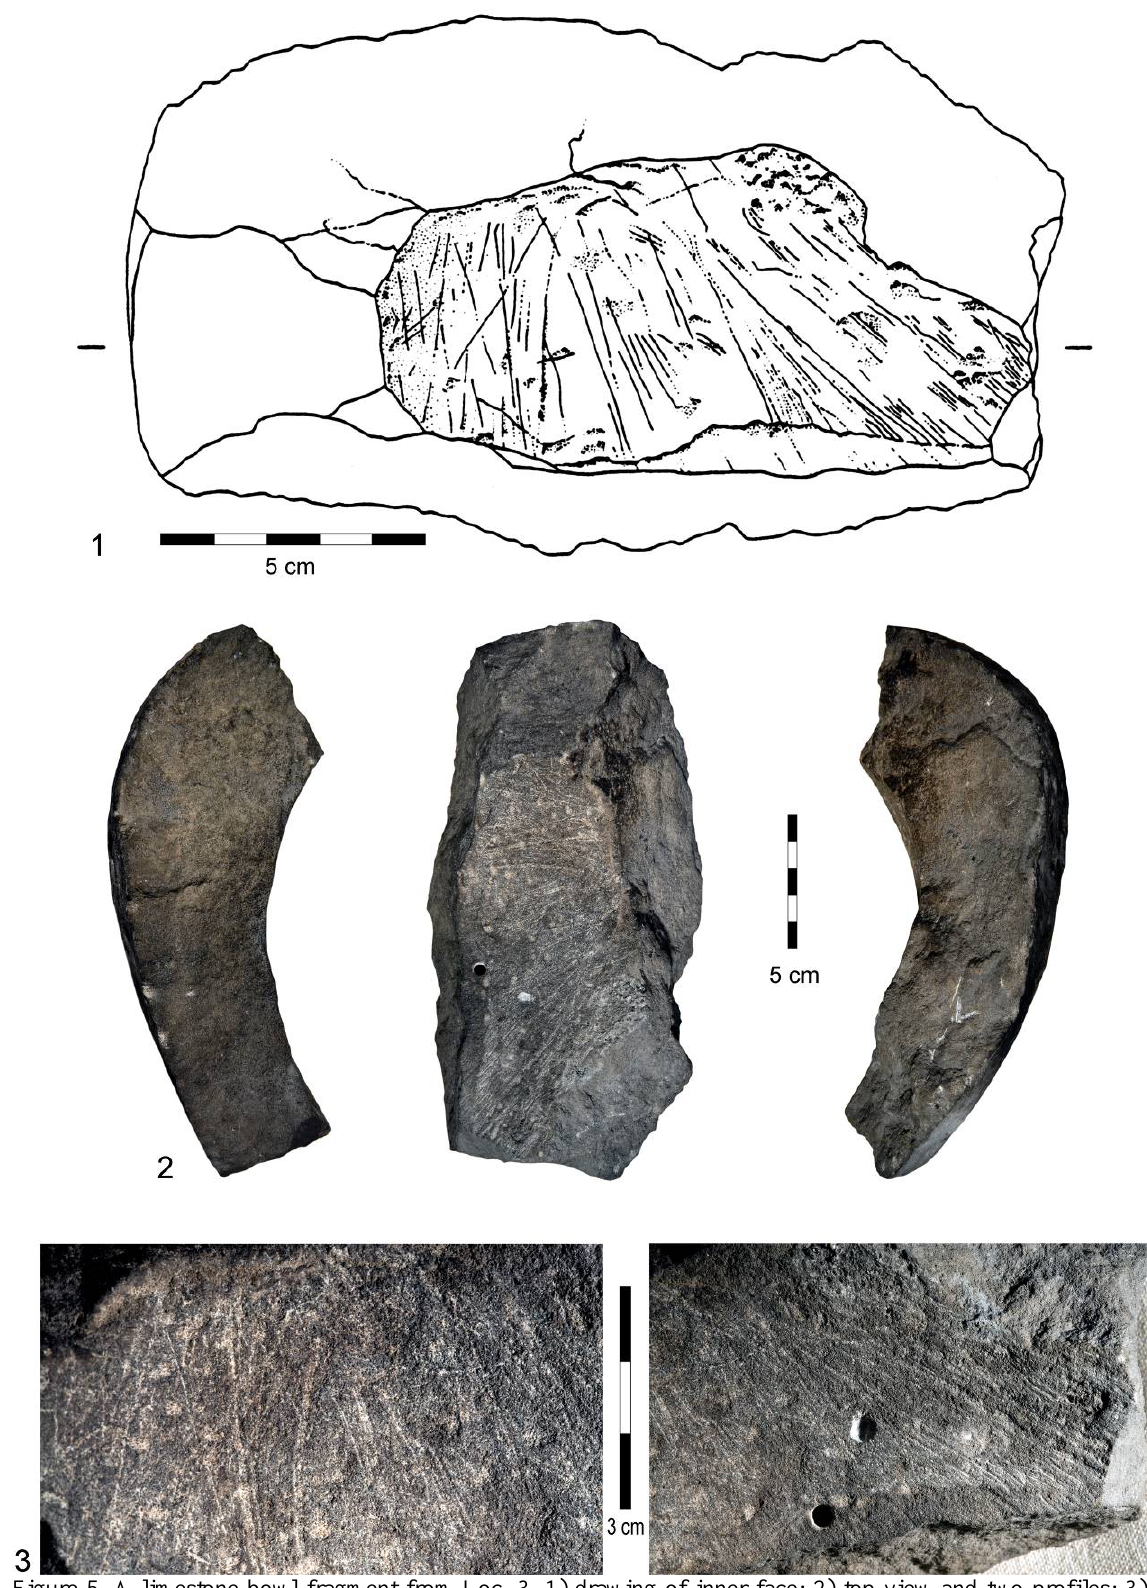
Figure 5. A limestone bowl fragment from Loc. 3. 1) drawing of inner face; 2) top view and two profiles; 3) close-up views of the incisions on the inner